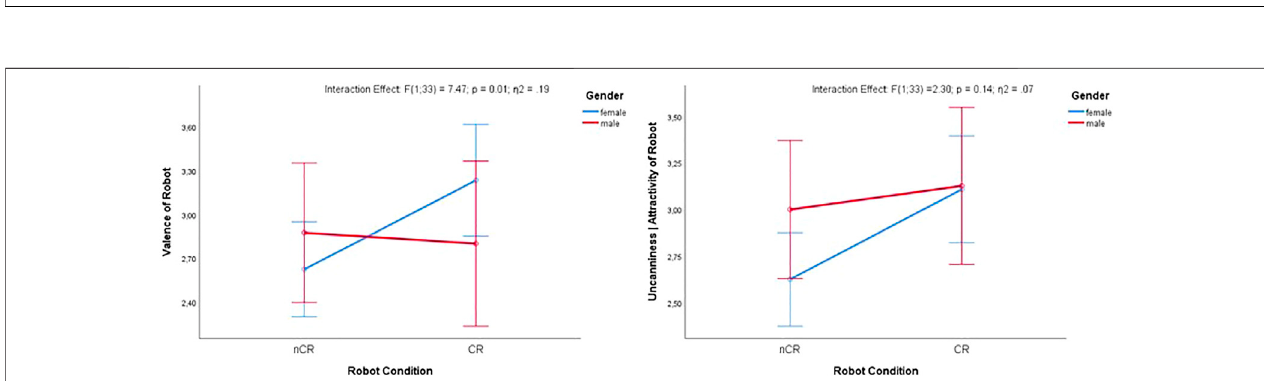
FIGURE 6 | showstheinteractioneffectbetweenrobotconditionandgenderofparticipantsregardingsomeoftherobotratings.nCRreferstothenon-conversational robot.CRreferstotheconversationalrobot.Theresultsdemonstratethatwomenratedtheconversationalrobotmorepositivethanthenon-conversationalrobotwhilemen did not. Similar, but not signi fi cant, women rated the conversational robot more attractive than the non-conversational robot while men did not.